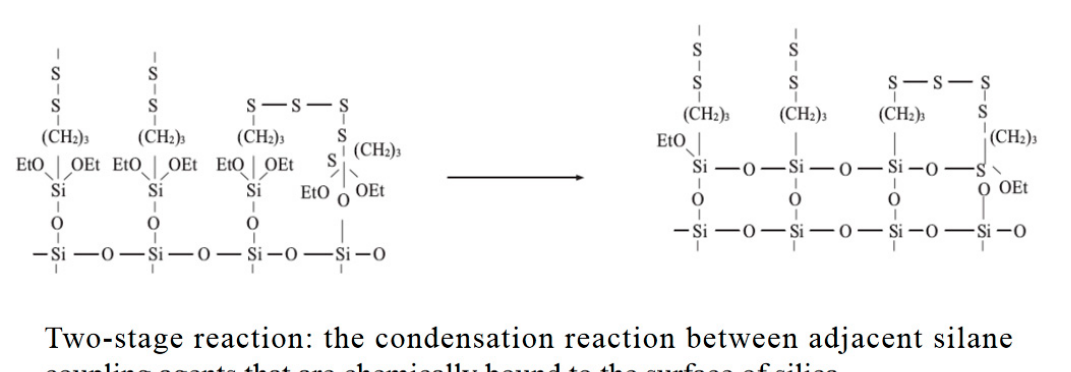
Figure 6. Two-stage reaction.